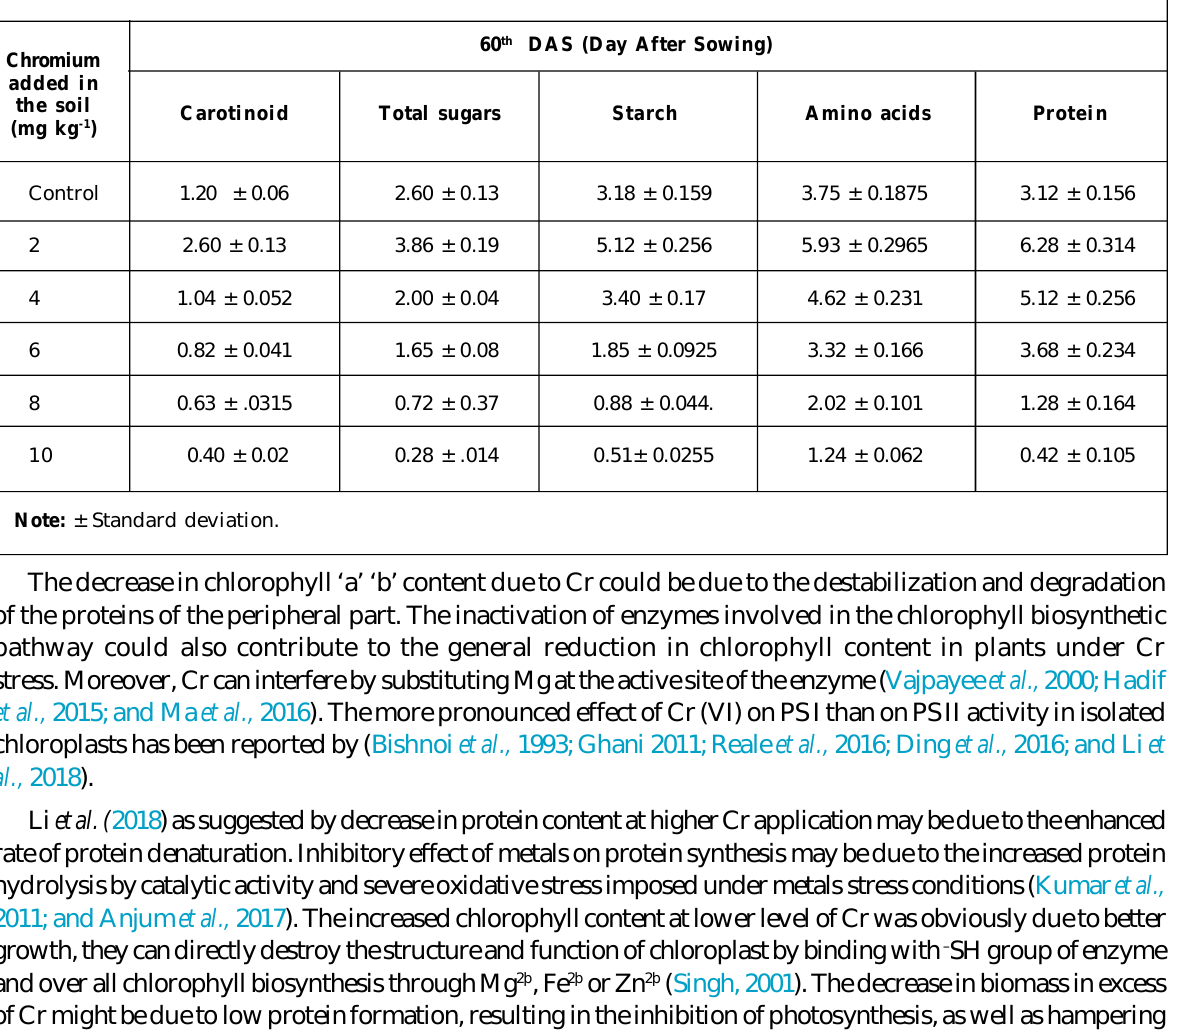
Table 2: Phyto toxicity of chromium on biochemical content of Horse gram. on 60 th DAS